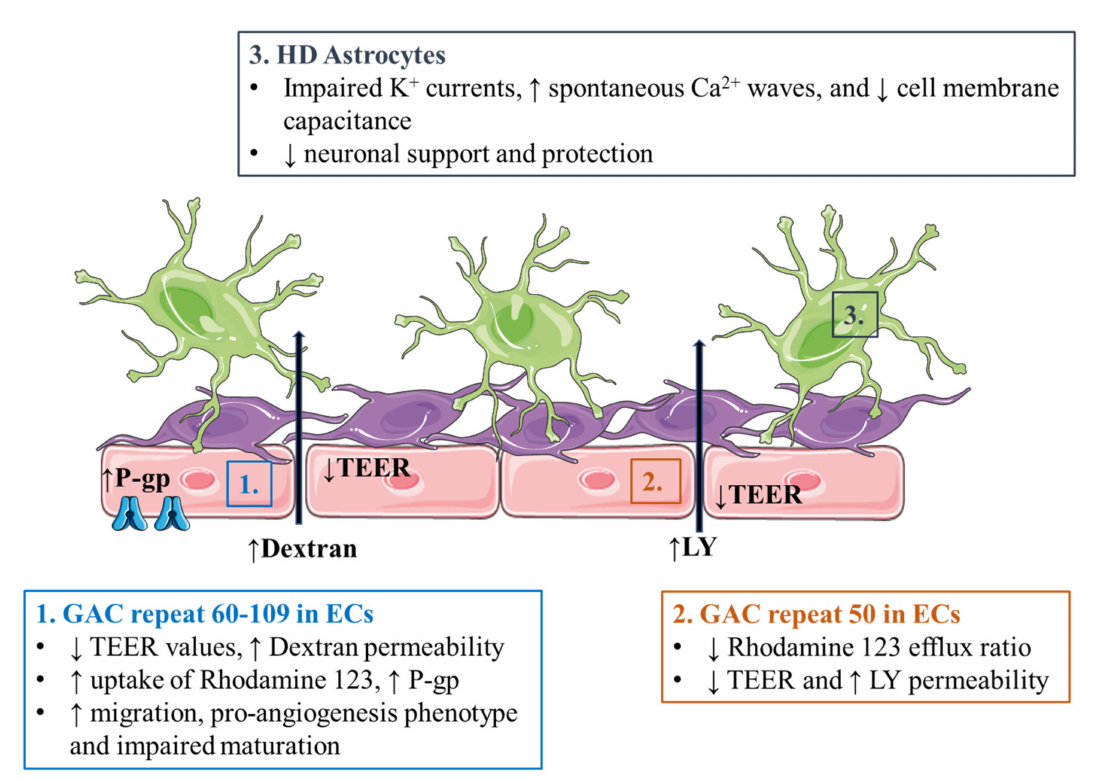
Figure 4. Schematic illustration of BBB dysfunction in HD based on iPSC-BBB